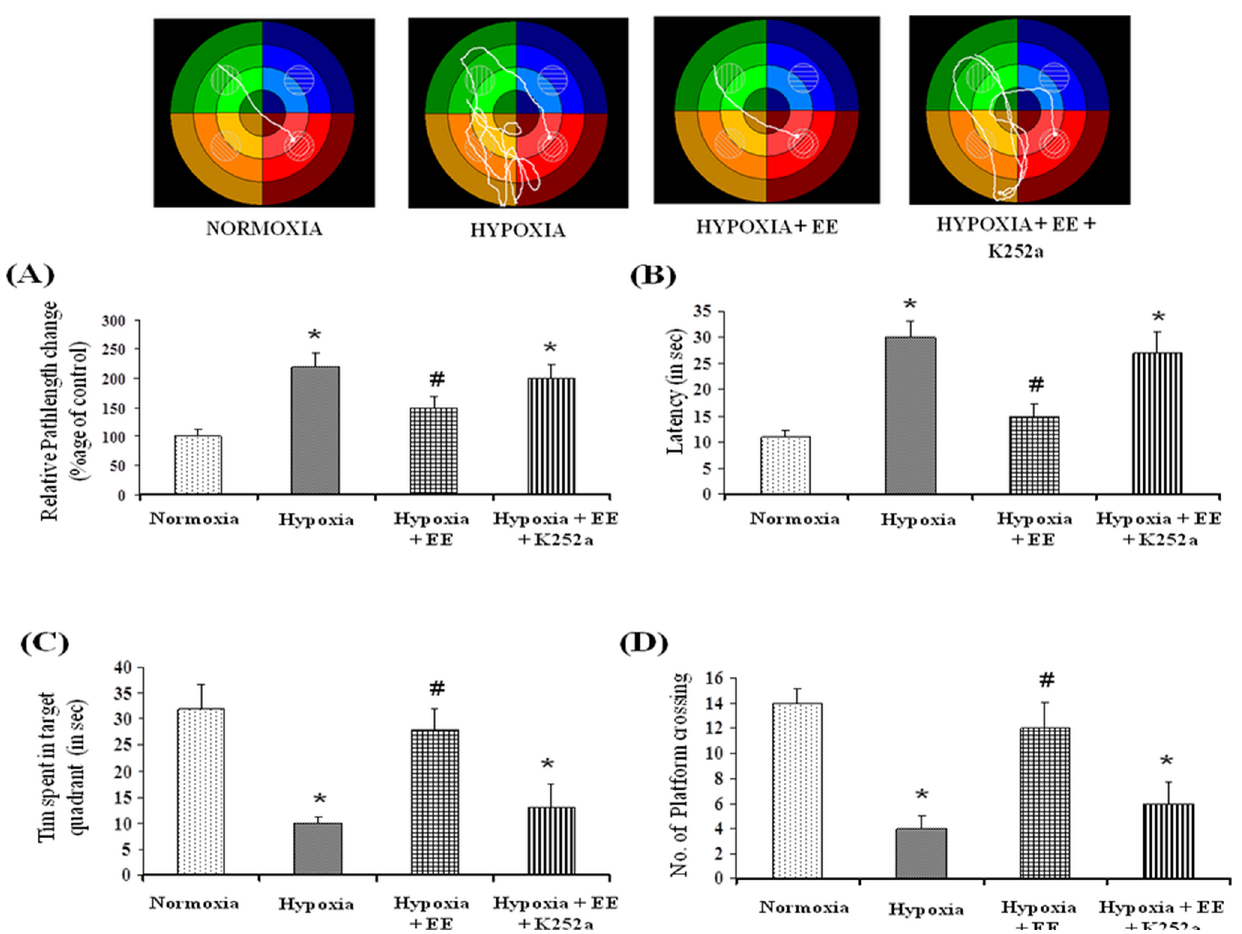
Figure 3. Effect of Trk antagonist on Behavior was studied using Morris Water Maze test and representative tack sheet showing memory test of Normoxia (I), Hypoxia (II), Enriched environment + Hypoxia (III) and Enriched environment + hypoxia + K252a (IV) exposure. Inhibition of TrkB with K252a nullifies the protective effect of Enriched environment on hypobaric hypoxia induced memory impairment as evident from increased pathlength (A) and latency (B) and decreased No. of platform crossing (C) and time spent in target quadrant (D). Data represents Mean 6 SEM. ‘‘*’’ and ‘‘ # ’’ represents p , 0.001 when compared to control and hypoxic group whereas ‘‘**’’ represents p , 0.05 when compared to hypoxic